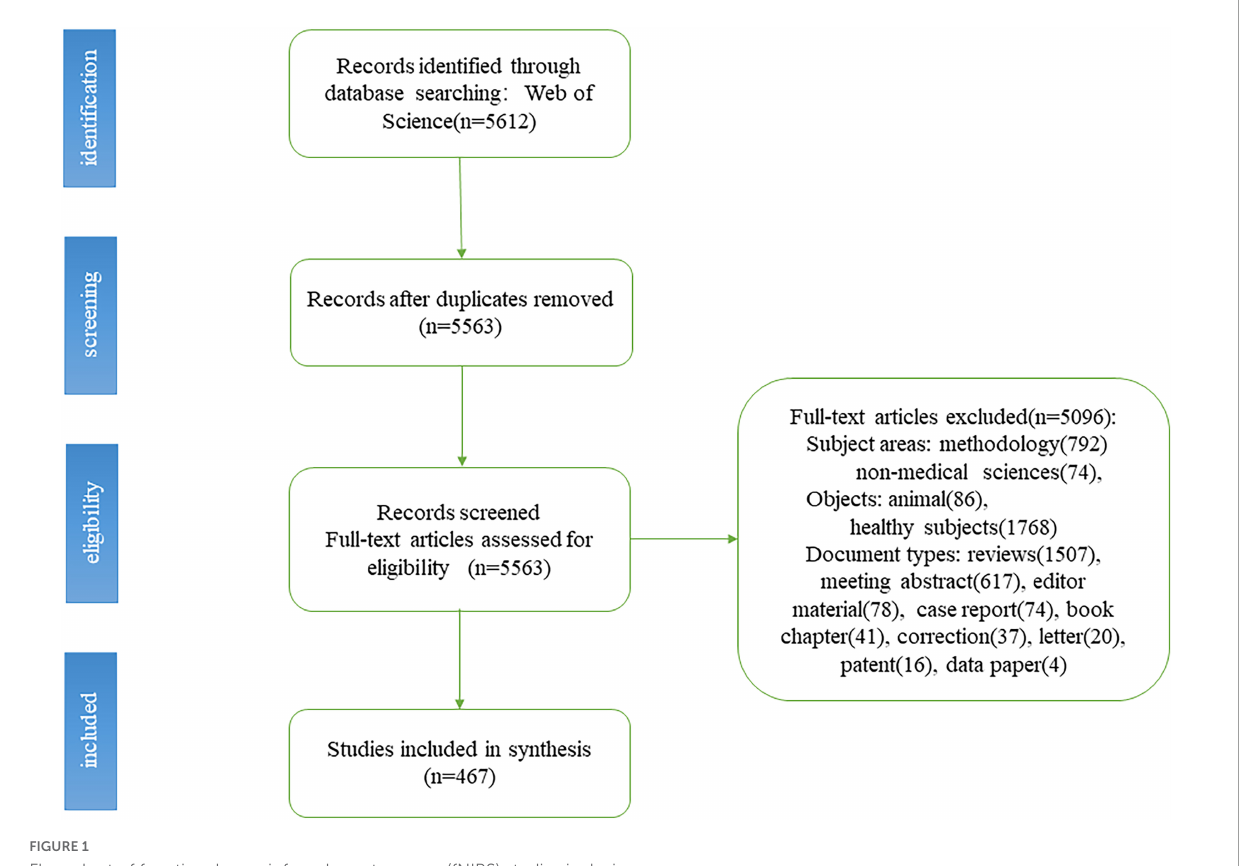
FIGURE1 Flow chart of functional near-infrared spectroscopy (fNIRS) studies inclusion.